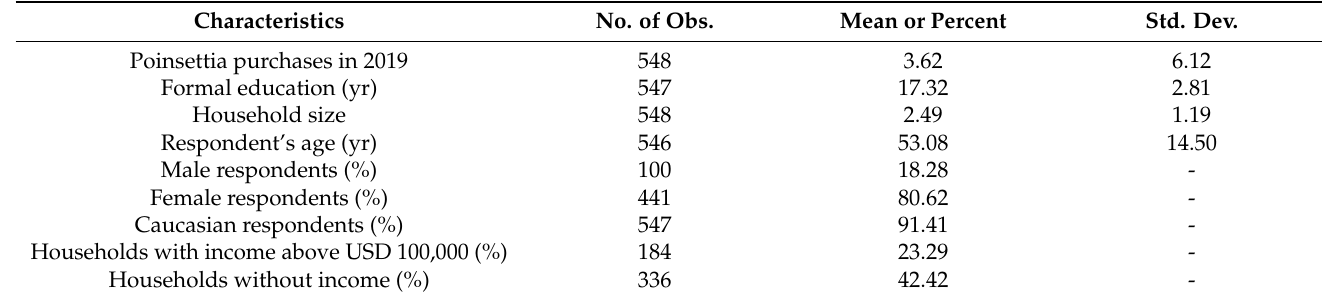
Table 1. Respondents’ previous poinsettia purchases and socioeconomic